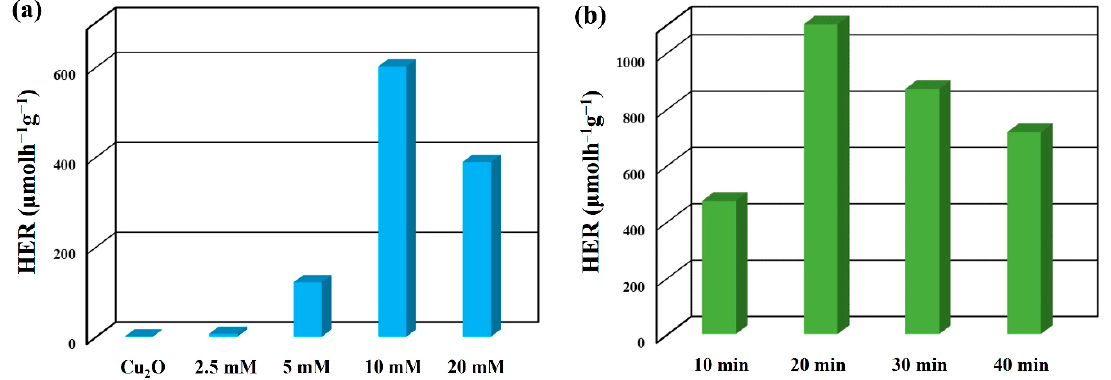
Figure 5. The average HER of the Cu 2 O/CuS/ZnS nanocomposite grown at different ( a ) ZnS precursor concentrations and ( b ) reaction times under blue LED light irradiation.